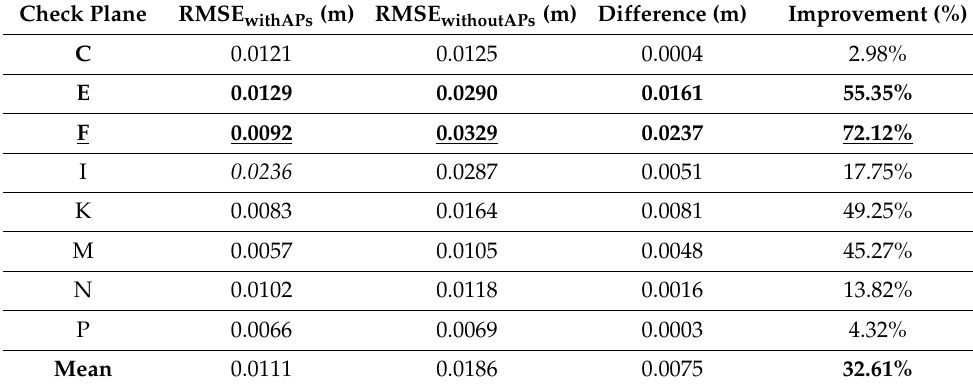
Table 11. RMSE of each check plane for dataset DATA1.